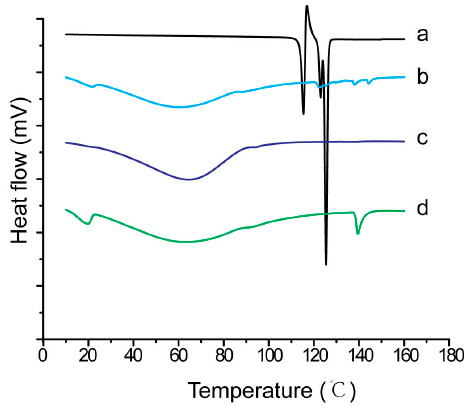
Figure 6. DSC curves of ( a ) pure nimodipine powder, ( b ) physical mixture of nimodipine and carriers, ( c ) S-SMEDDS of nimodipine with acacia and ( d ) S-SMEDDS of nimodipine with maltodextrin.